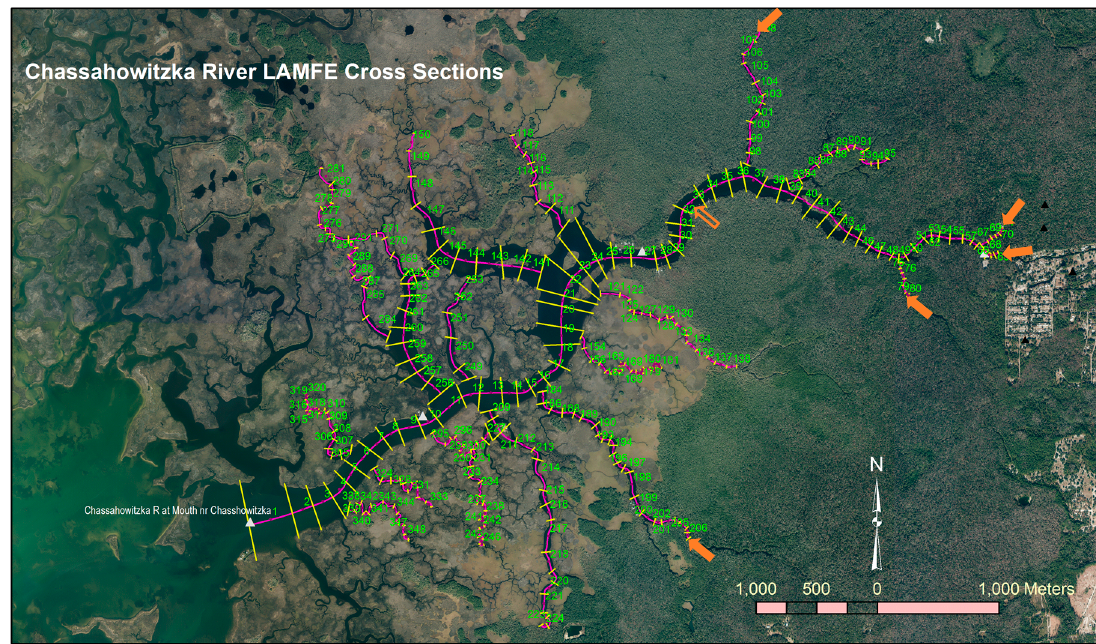
Figure 6. Cross-sections (yellow segments) that form the LAMFE grids for the Chassahowitzka River and its branches. Numbers in green are grid numbers in the longitudinal direction. Orange arrows are locations where SGDs enter the model domain (the unfilled arrow indicates the location that was randomly chosen for an unidentified SGD